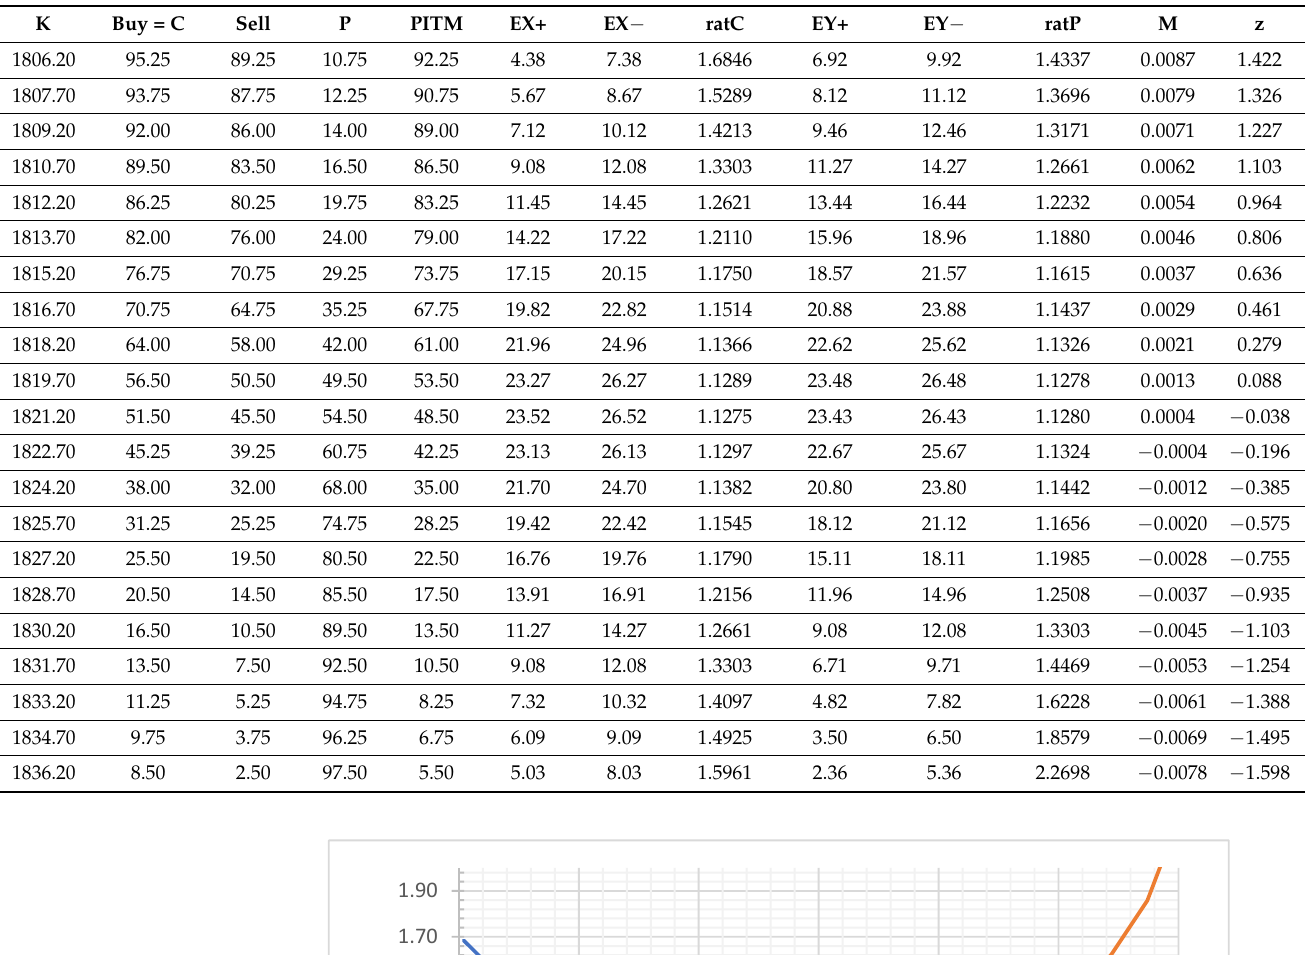
Table 2. Nadex one day Gold binary data of 8 February 2022 just before opening at gold price S 0 = 1822.